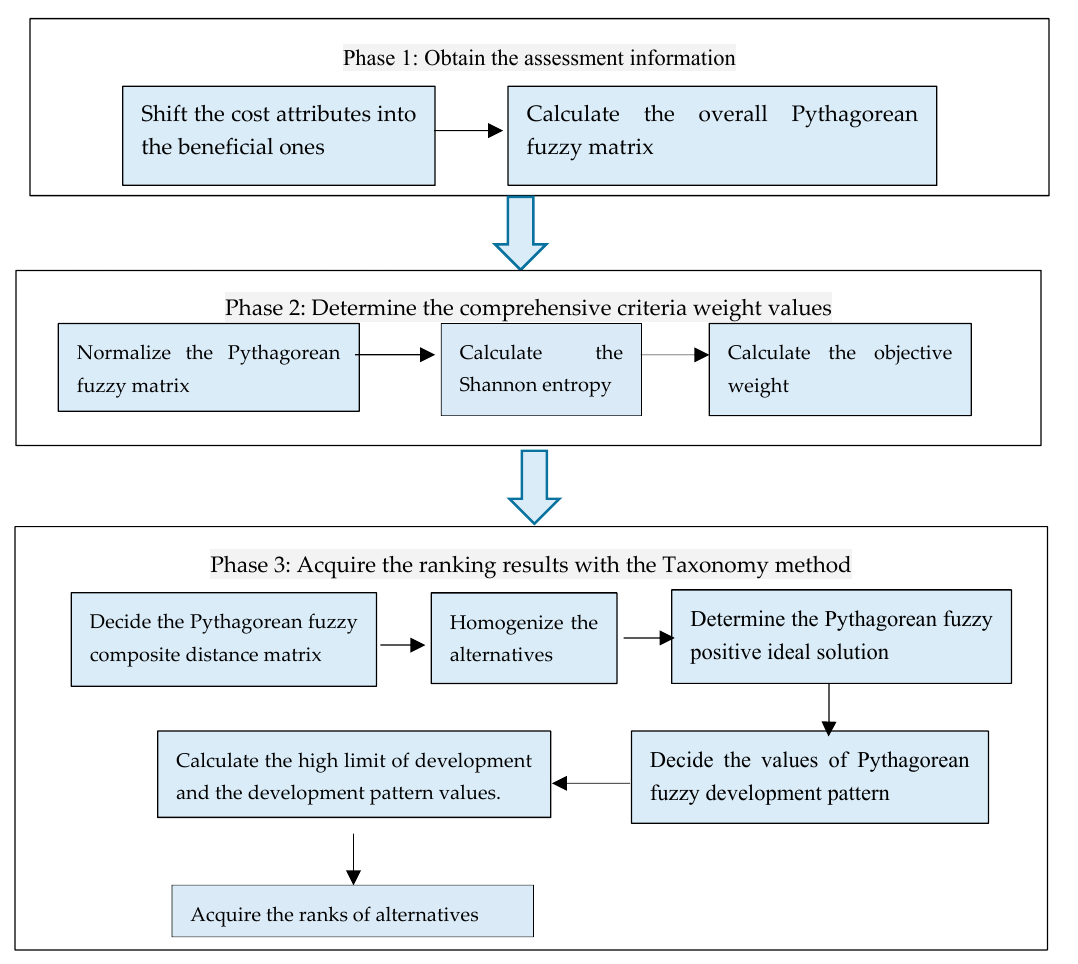
Figure 1. The structure of the presented method.